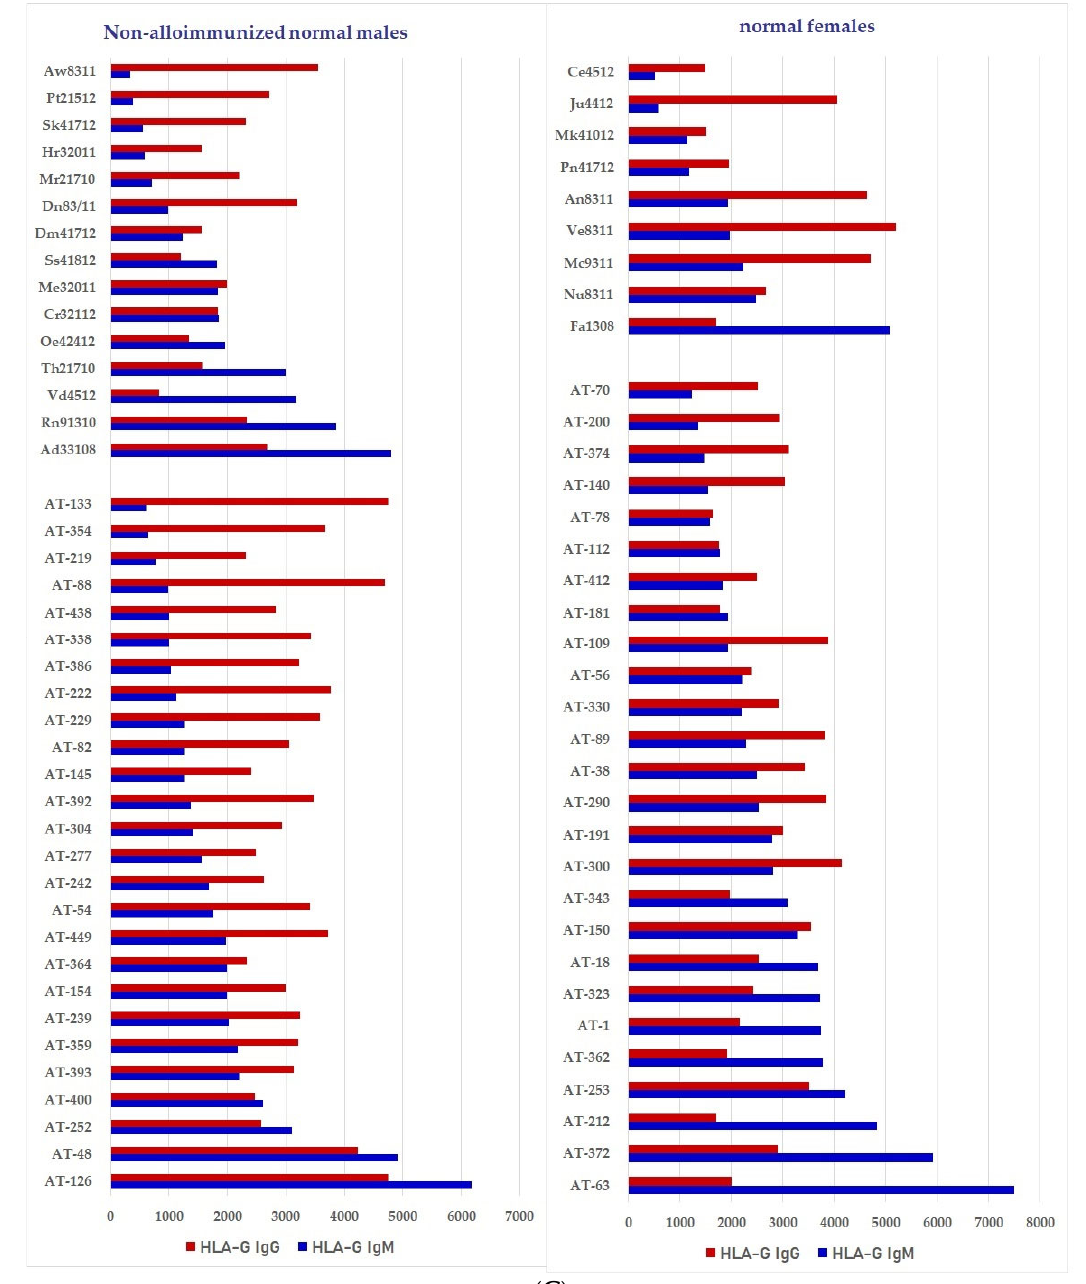
Figure 7. Documentation of IgM and IgG antibodies against HLA class Ib molecules in the sera of male (non-alloimmunized) and female (volunteers). Interestingly, naturally occurring IgM antibodies are more prevalent than IgG for HLA-E ( A ). In contrast, naturally occurring IgG antibodies are more prevalent than IgM for HLA-F and HLA-G ( B , C ). Simultaneous prevalence of higher IgM than IgG in HLA-E, HLA-F and HLA-G, suggests that these individuals may be experiencing induction of IgM due to various pathological conditions such as inflammation, injury and other disorders. ( A )